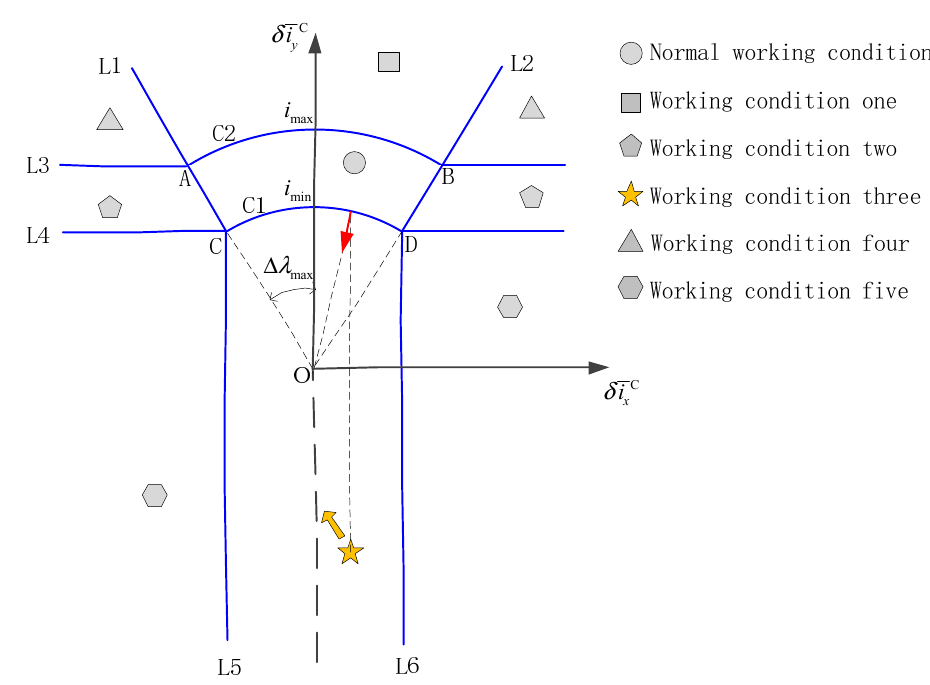
Figure 10. The NSSK in working condition three. In Figure 10, the starting point of the straight arrow is located between the CD arc segments on the C1 circle, indicating that the duration of the SK is shortest. The control point of the SK is dynamically adjusted with the fluctuation of the current mean orbital inclination vector. The 45 ◦ arrow points to the normal zone, indicating that working condition three will enter the normal working condition in one direction. Working